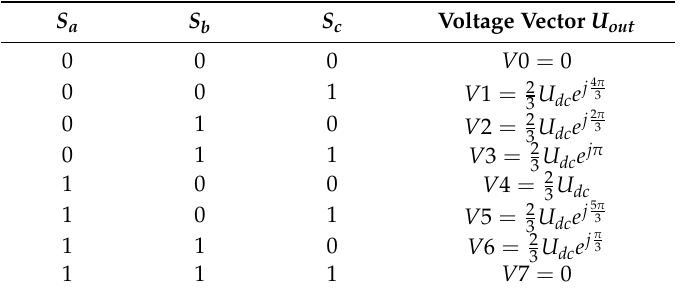
Table 2. Switching state and voltage vector.